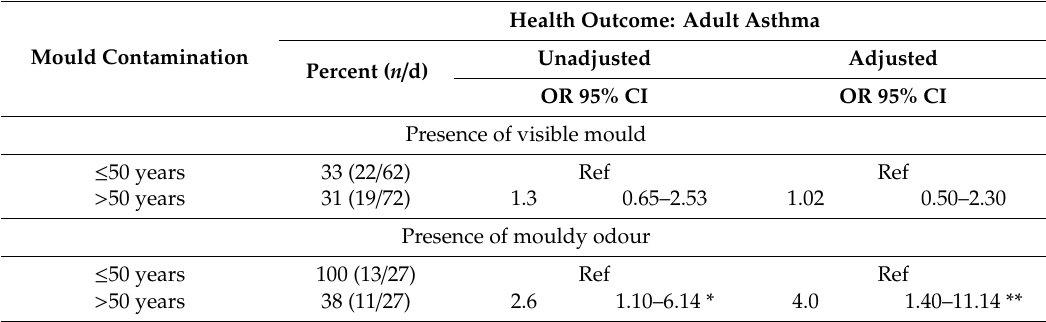
Table 4. Indoor mould and risk of asthma in adults aged over 50